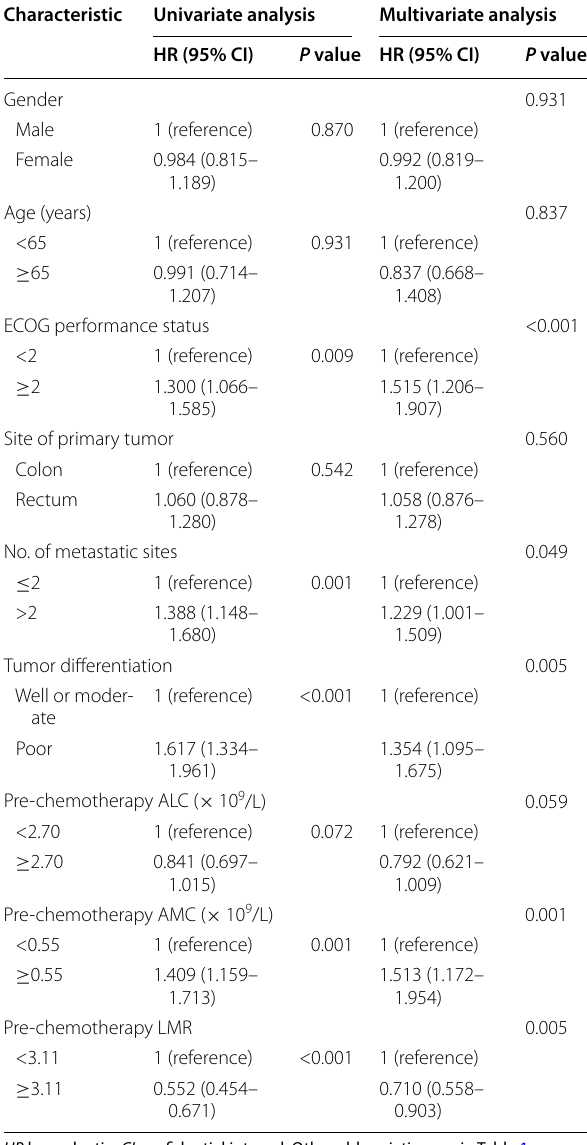
HR hazard ratio, CI confidential interval. Other abbreviations as in Table